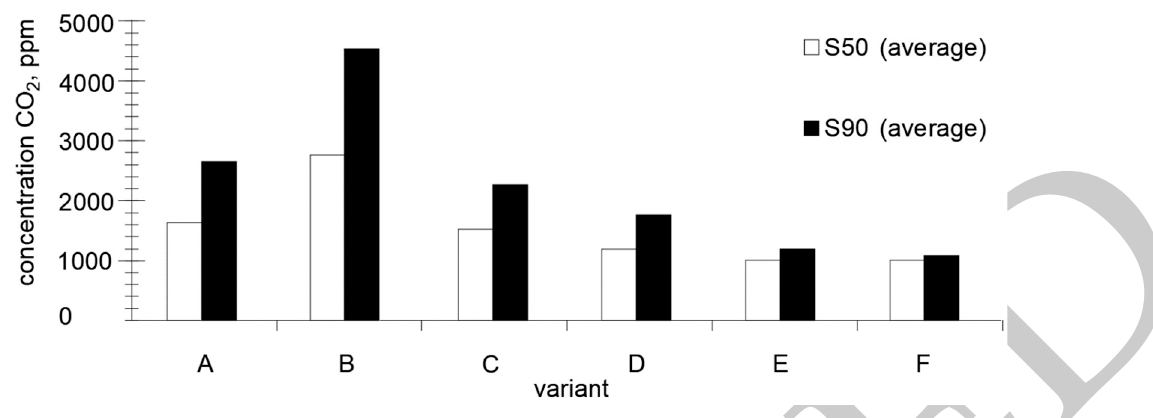
Figure 5. Average concentration of carbon dioxide during the lesson in classrooms throughout the heating season, with different variants of building ventilation.